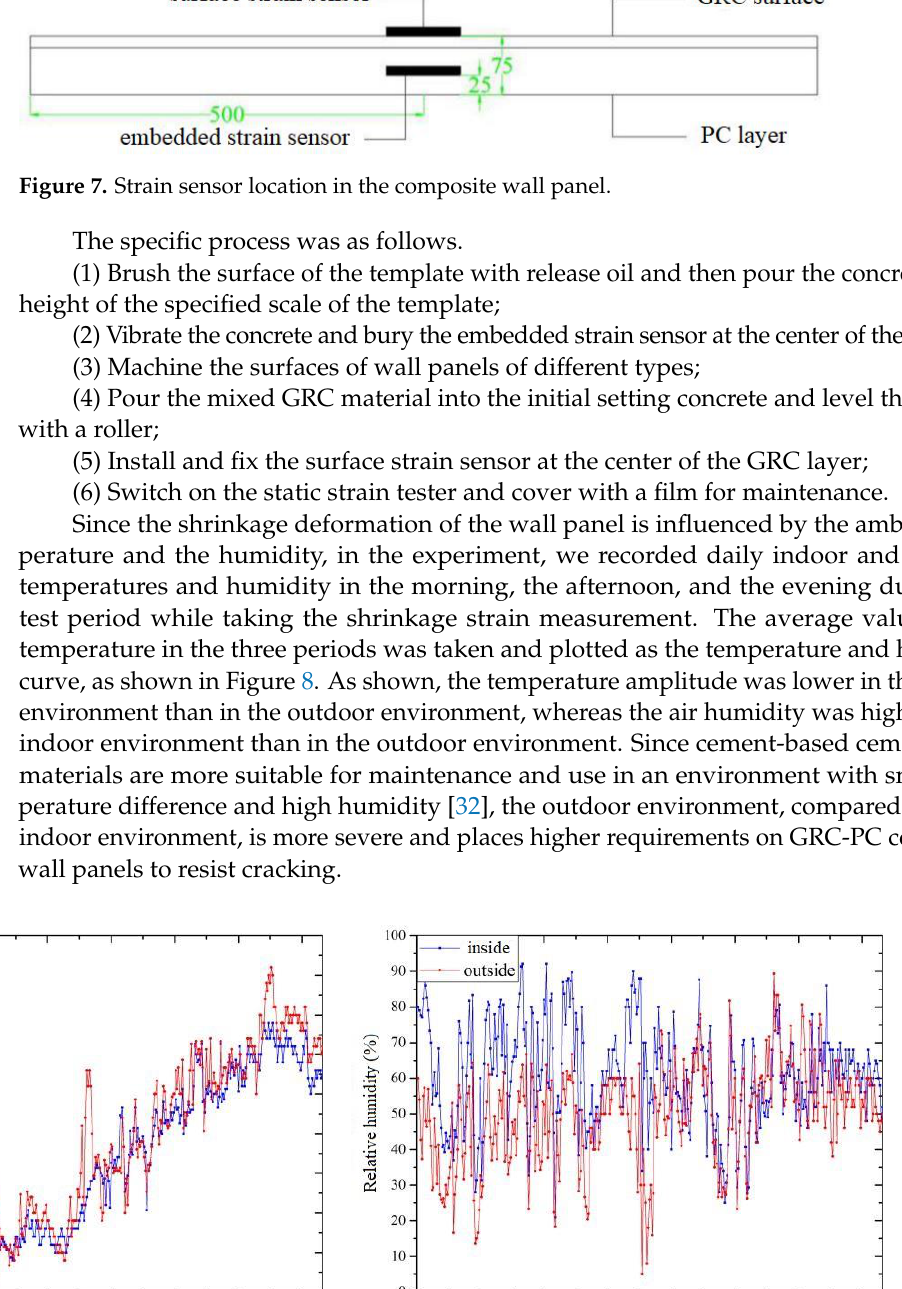
Figure 7. Strain sensor location in the composite wall panel.